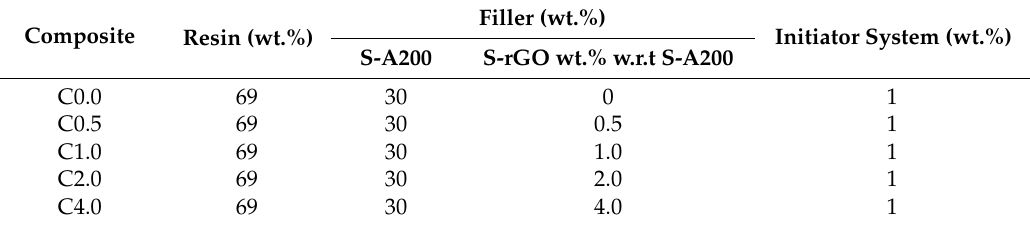
Figure 1. Schematic of BisGMA/TEGDMA (bisphenol A glycidyl methacrylate/ triethylene glycol dimethacrylate) dental composites filled with S-A200 and S-rGO. Table 1. Composition of the experimental dental composites C0.0–C4.0.